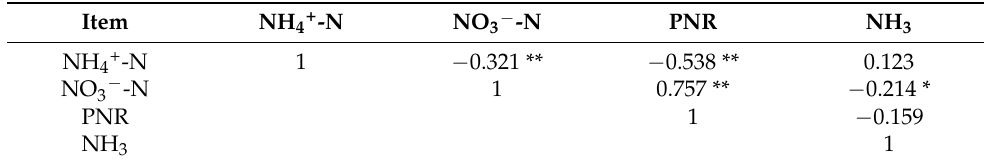
Table 3. Pearson correlation analysis between NH 4+ -N, NO 3 − -N, potential nitrification rate (PNR), and ammonia volatilization (NH 3